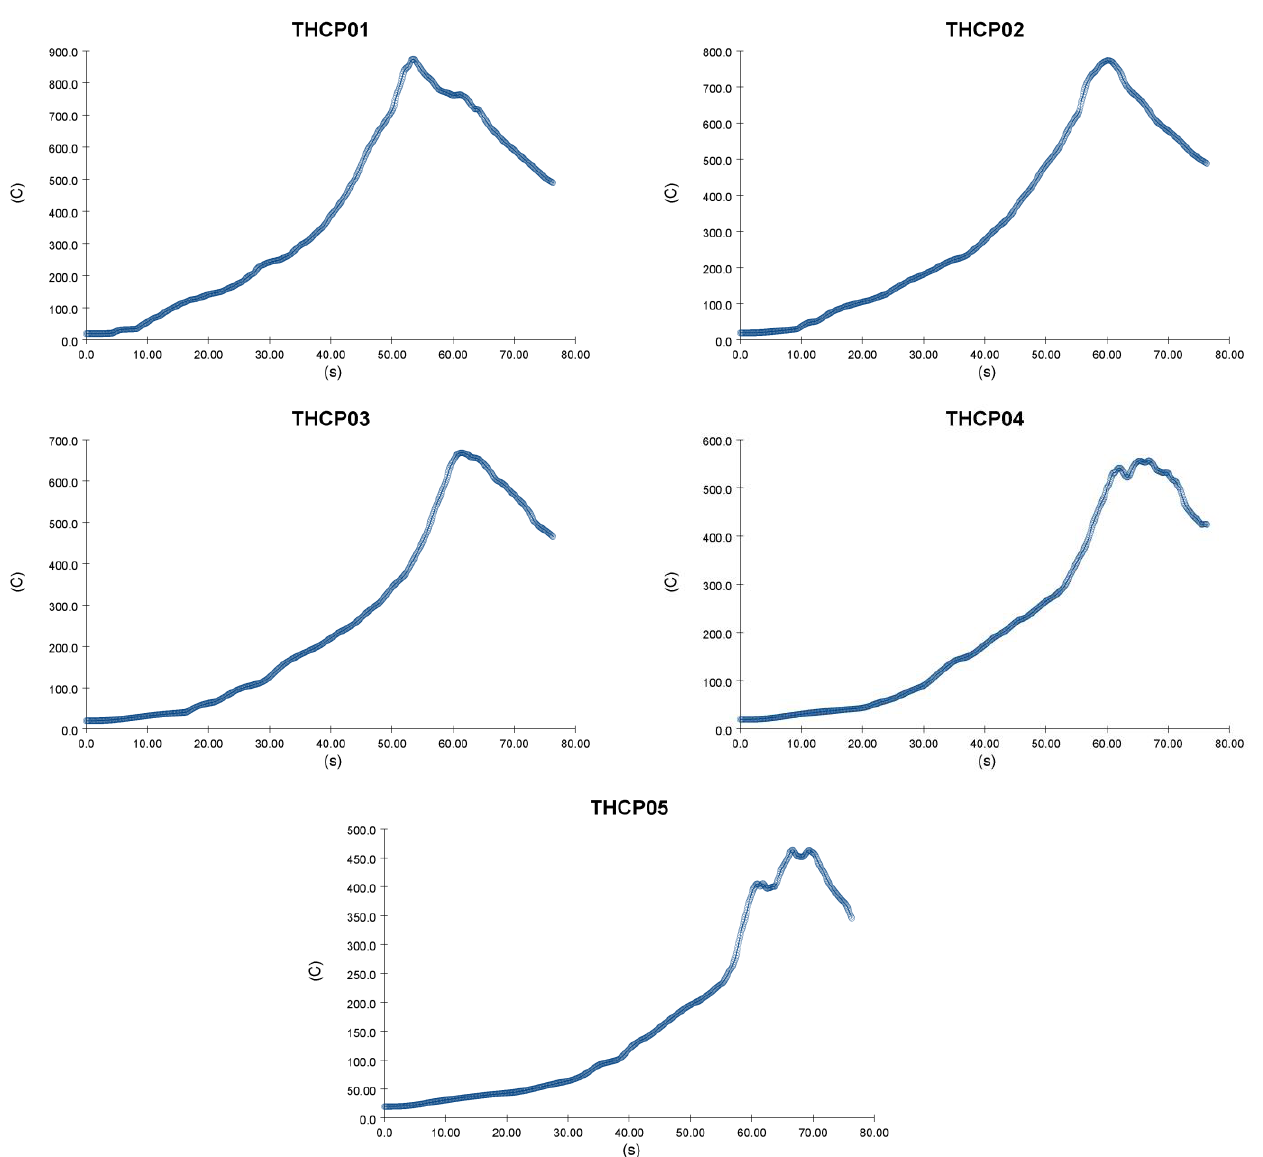
Figure 17. Room temperature evolution in time, in the first seconds of the fire simulation (Hypothesis 2).